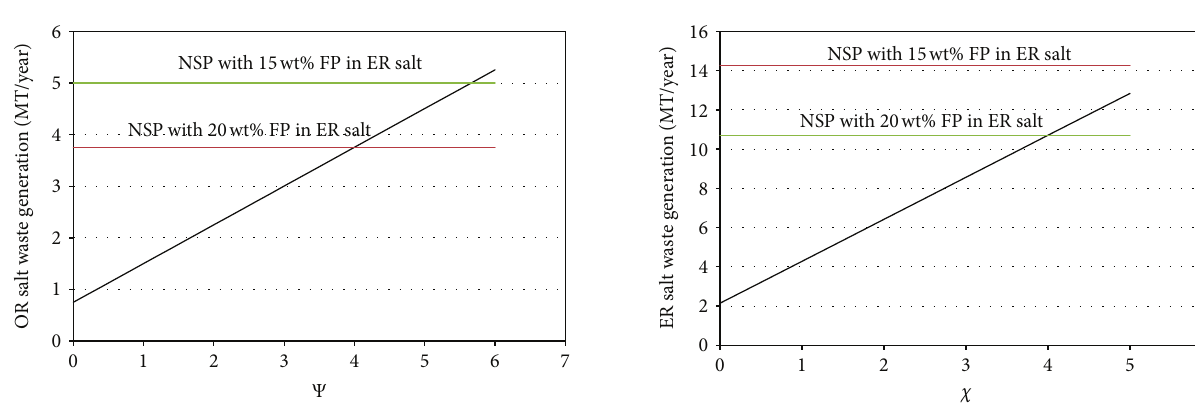
Figure 6: Comparison of OR salt waste generation rates for 100MTHM/year facility for selective process (black curve) to non- selective process (NSP) with two different levels of fission product accumulation in the OR.